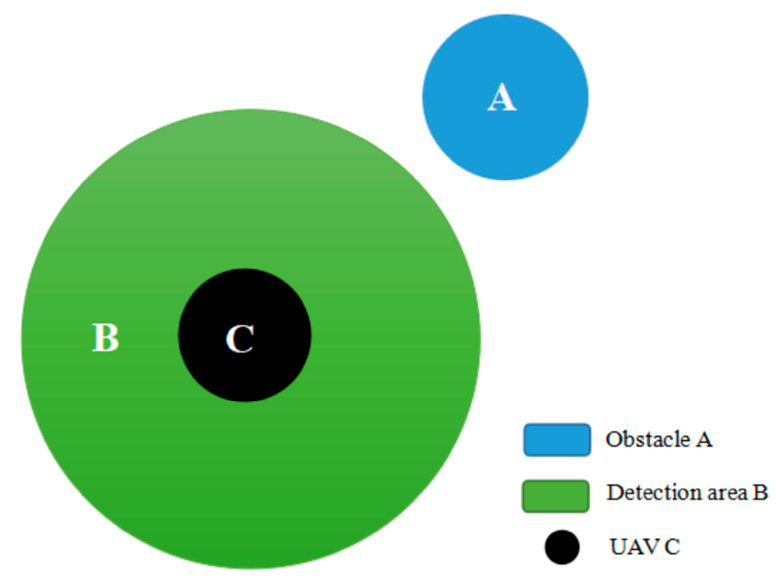
Figure 2. Abstract topology representation of UAV area.